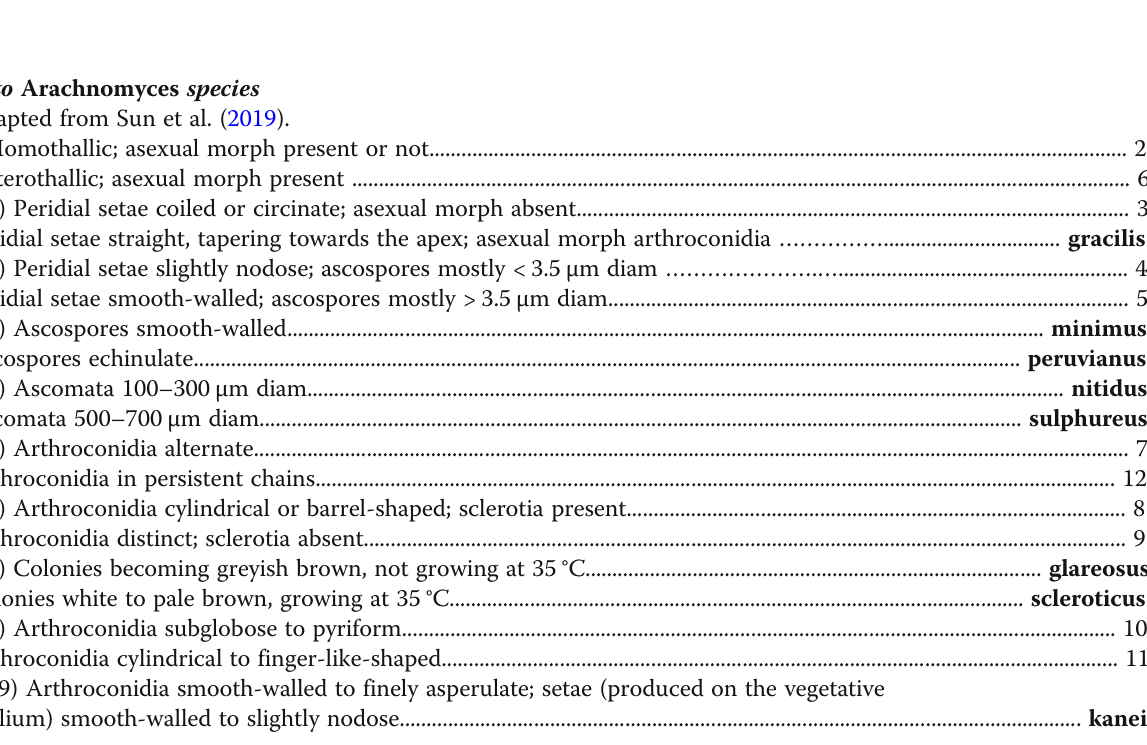
KEYS Key to Arachnomyces species Adapted from Sun et al.